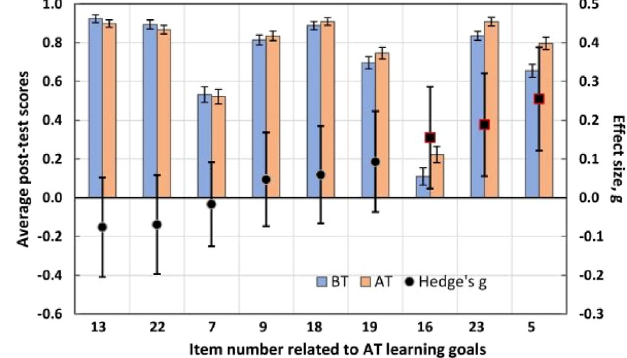
FIG. 5. Average overall pretest and post-test E-CLASS scores for men in the BT (blue, N ¼ 1067 ) and AT (orange, N ¼ 1201 ) offerings. Error bars are 95% confidence intervals.